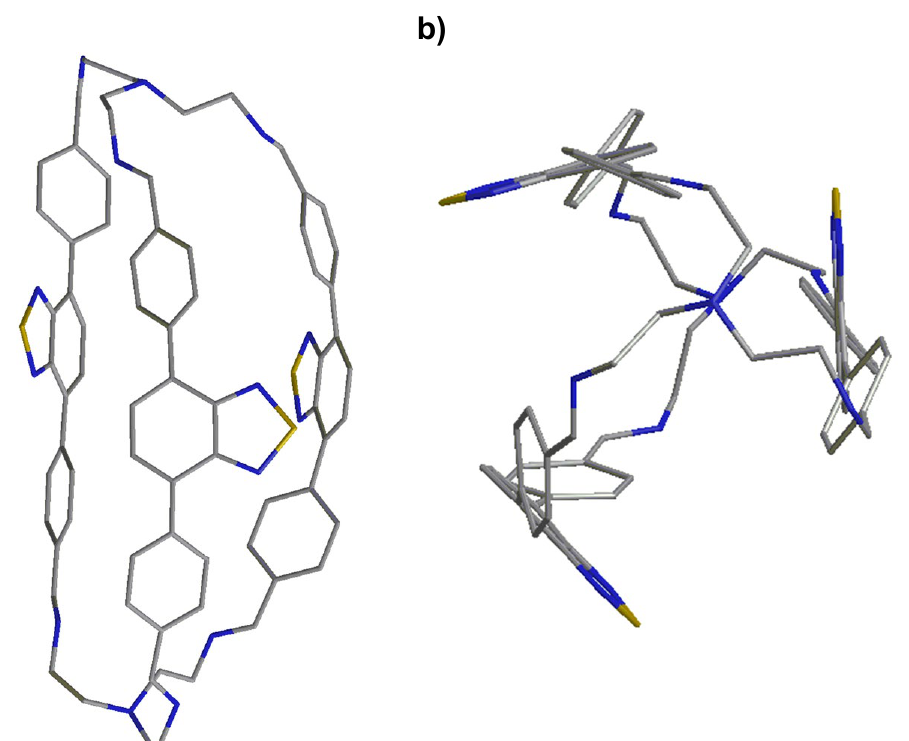
Figure 2. DFT-optimized structures of cage 1 : ( a ) side view, ( b ) top view. Color code: C, gray; N, green; S, yellow. Protons have been omitted for clarity.